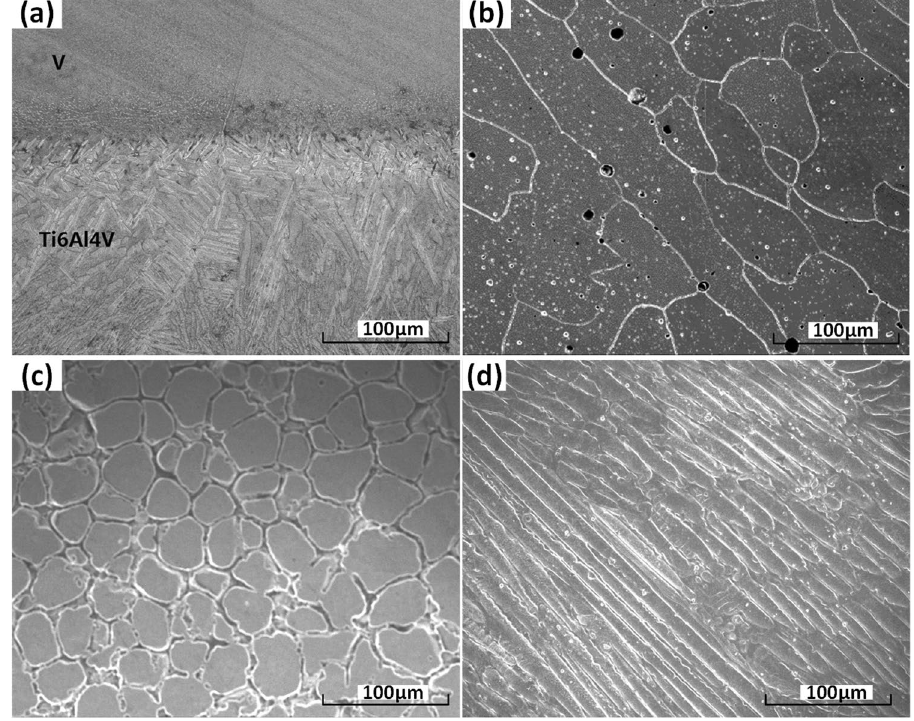
Figure 10. The microscopic images of microstructure at the four sites: ( a ) with maximum wt% of Ti; ( b ) with maximum wt% of V; ( c ) with maximum wt% of Cr; ( d ) with maximum wt% of Fe.